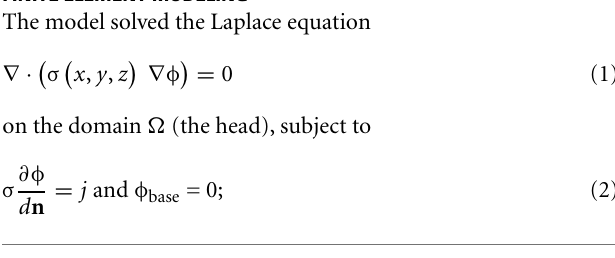
Table 1 | Conductivities assigned to tissues in our